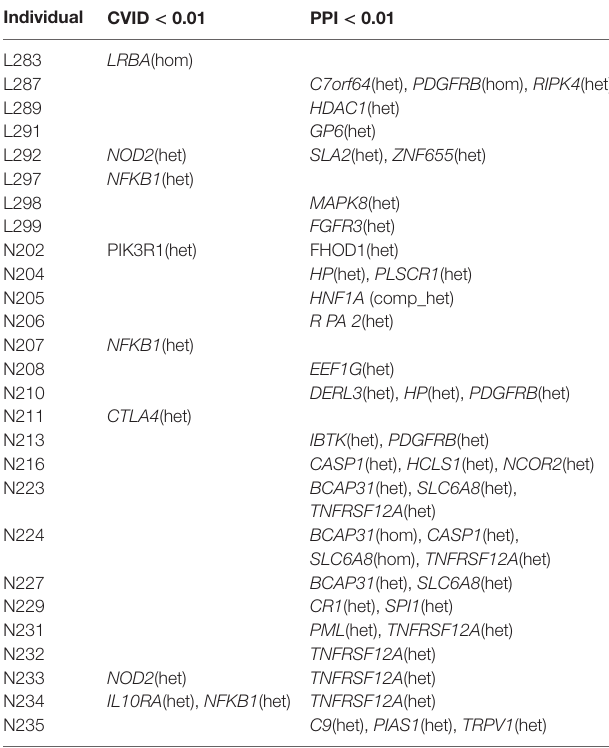
TaBle 2 | Genes with Loss-of-Function (LoF) homozygous or heterozygous variants in common variable immunodeficiency (CVID) candidate genes and interacting